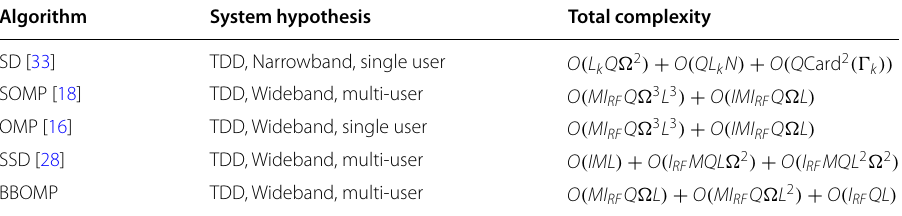
Table 1 Complexity comparison results of different schemes